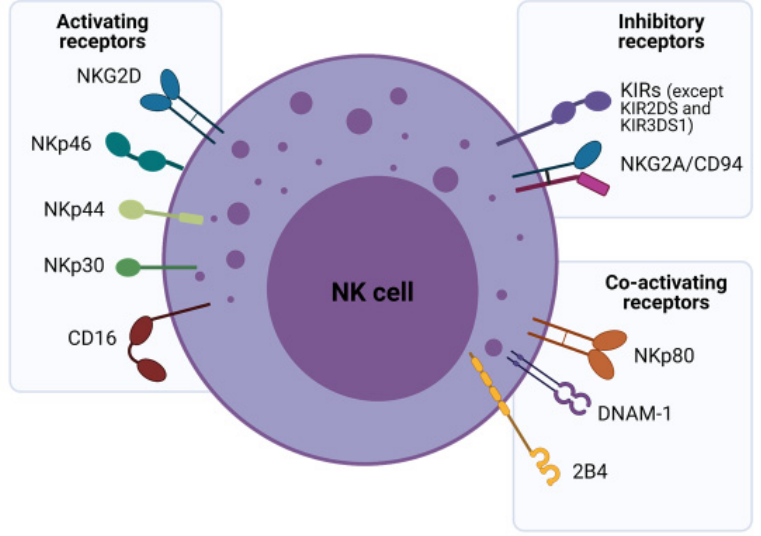
Figure 1. The major activating, co-activating and inhibitory receptors expressed on the surface of NK cells. Abbreviations: 2B4, also known as CD244; CD, cluster of differentiation; DNAM-1, DNAX accessory molecule-1; KIR, killer cell immunoglobulin-like receptors; NKG2, also known as CD159; NKp30, 44, 46, 80, natural cytotoxicity receptors.